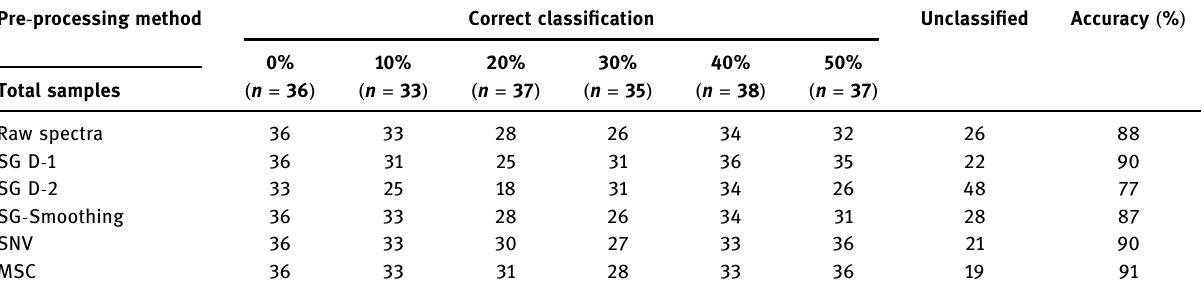
Table 7: PLS - DA model performance for classi fi cation of SPI - added in butter fl y - pea extract powder based on various pre - processed spectra